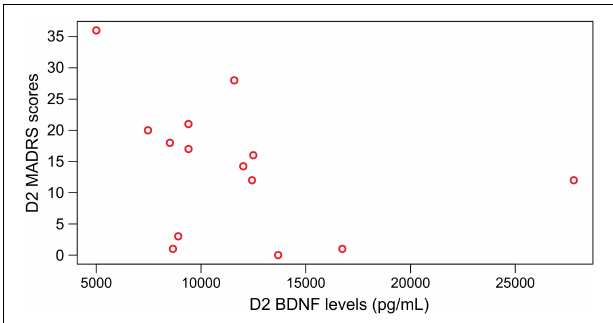
FIGURE 5 | Significant negative Spearman correlation between BDNF levels and MADRS scores at D2 for patients that were treated with ayahuasca ( n = 14; Spearman test, p ≤ 0.05 rho =